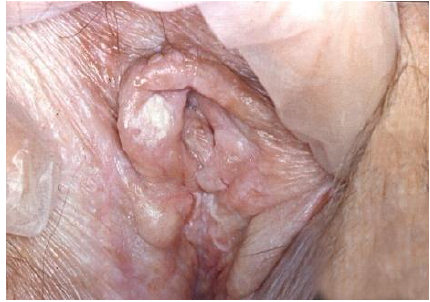
Figure 10. Vulvar HSIL. (before the application of Acetic